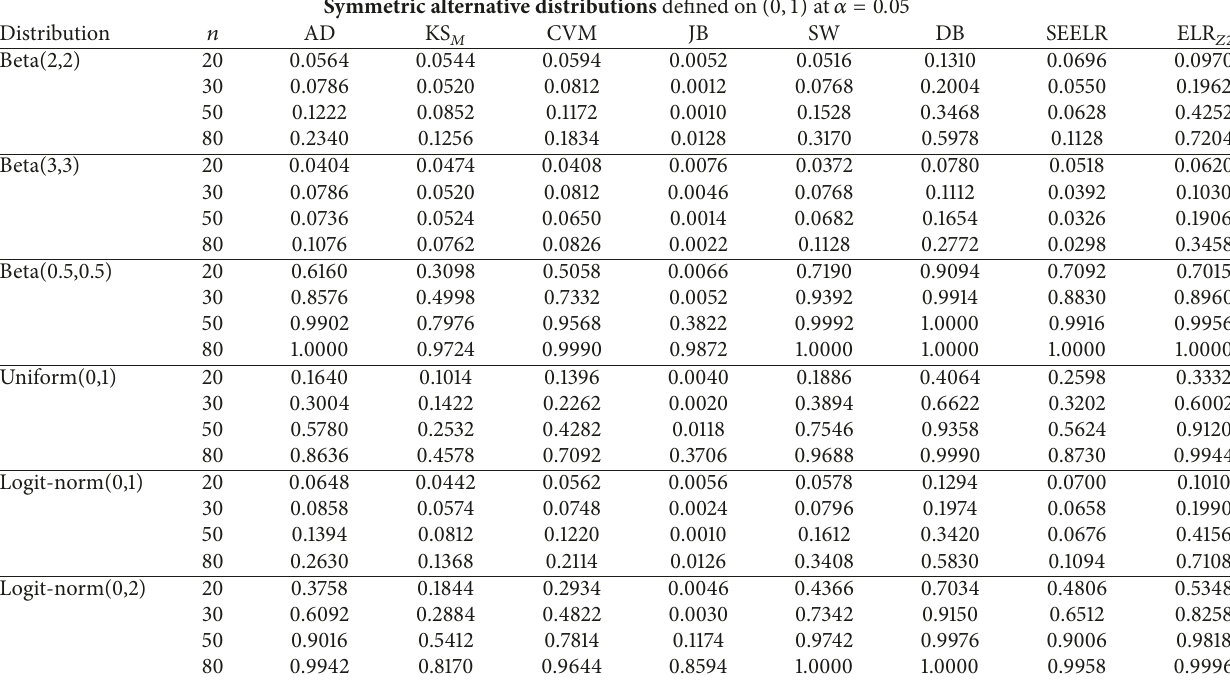
Table 6: Results of the Monte Carlo power comparisons based on samples with sizes (𝑛) from symmetric alternative distributions defined on (0, 1) at 𝛼 = 0.05